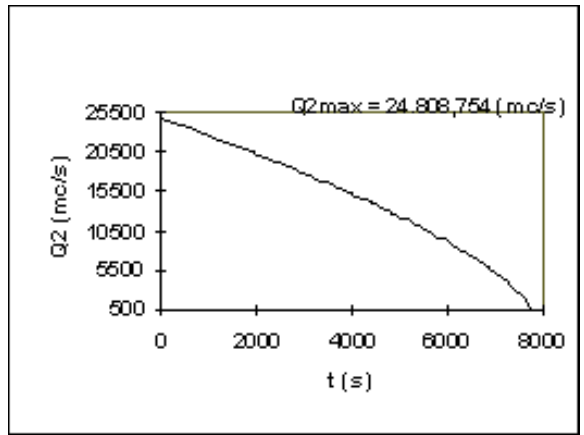
Figure 7. San Giuliano dam-break outflow hydrograph according to the methods of Sole et al. (1997). Source: [37]. Source: